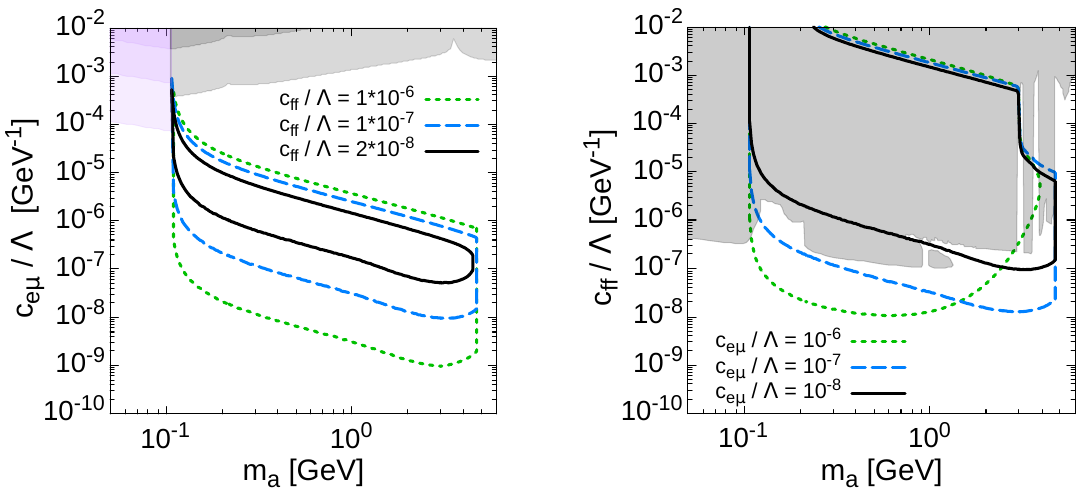
Figure 2 . The contour plots of 95 % C.L. sensitivity regions for the pseudoscalar-type interaction in the m a − c eµ / Λ plane (left) and the m a − c ‘‘ / Λ plane (right). Left: the purple shaded areas are excluded by E137 for c ff / Λ = 10 − 6 (light), 10 − 7 (medium), and 2 × 10 − 8 GeV − 1 (dark). The gray shaded areas are excluded by µ → eγ for c ff / Λ = 10 − 6 (light) and 10 − 7 (medium) in the case of Λ = 1 TeV. Right: the gray shaded area shows the current exclusion region given in ref.